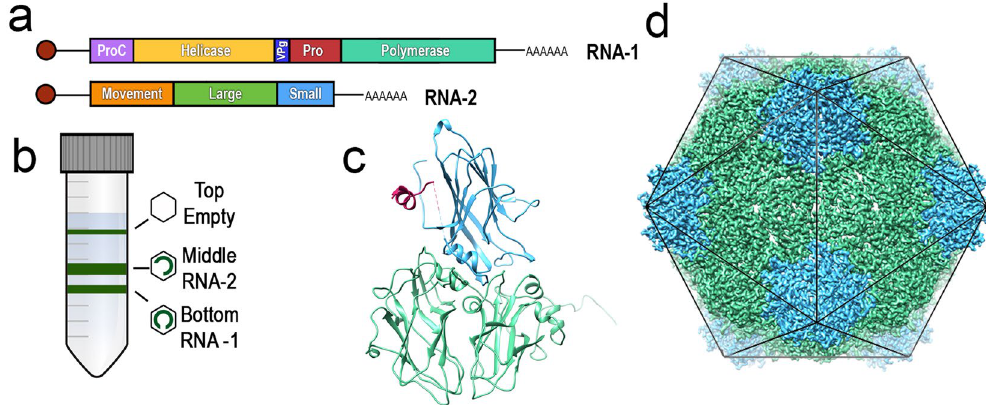
Figure 1. An introduction to Cowpea mosaic virus (CPMV). ( a ) CPMVs single stranded bipartite RNA genome. RNA-1 is ~6 kb in length and encodes viral proteins required for replication. RNA-2 is ~3.5 kb in length and encodes the structural coat proteins and the movement protein required for moving CPMV virions from cell to cell. ( b ) Gradient centrifugation of wild-type CPMV permits separation into three components. Empty CPMV particles sediment at the top (CPMV-T), CPMV containing RNA-2 sediments in the middle (CPMV-M) and RNA-1 containing CPMV particles sediment at the bottom of a density gradient (CPMV-B). ( c ) An asymmetric unit of CPMV empty virus-like particle (eVLP), (PDB 5a33). The large coat protein subunit (L subunit, green) and the small coat protein subunit (S subunit, blue). The C terminal extension, only visualised in a eVLP is coloured pink. ( d ) The icosahedral organisation of CPMV using the EM derived map of eVLP (EMD- 3014). Each of the 60 asymmetric units comprises one copy of the L subunit and the S subunit (coloured as in 1C). A view down the two-fold axis is